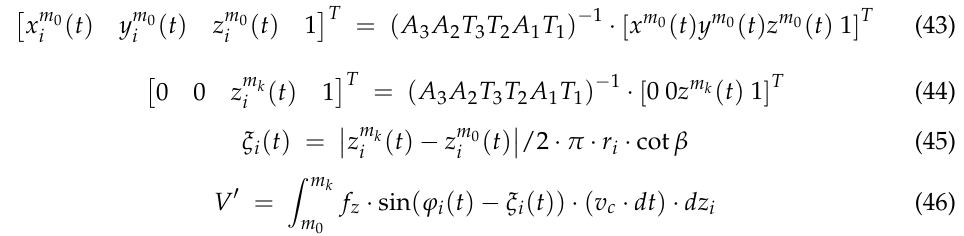
Figure 26. The solved and measured results of specific tangential-force energy of milling cutter. ( a ) scheme 1; ( b ) scheme 2.